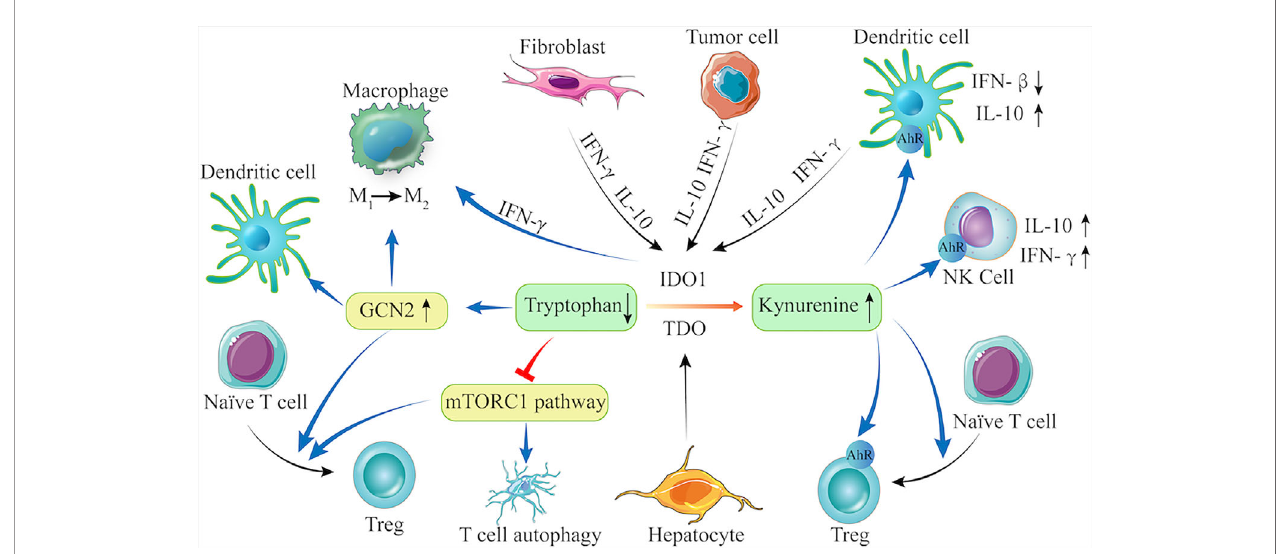
FIGURE 1 | The Try-IDO1/TDO-KYN pathway and immune escape. IDO1 is constitutively expressed in fi broblast, tumor cells, and DCs, and can be upregulated by IL-10 and IFN- g , whereas TDO is only expressed in hepatocytes. When IDO1 and TDO are activated, they promote Try degradation and KYN accumulation. Try depletion can activate GCN2 and inhibit the mTORC1 signaling. The KYN can bind to AhR in NK cells, Tregs, and DCs. Therefore, the Try-IDO1/TDO-KYN pathway cooperatively modulates immune cells (e.g., DCs, macrophage, Treg, and T cells) to regulate anti-in fl ammatory cytokine production, leading to enhanced immunosuppression in the tumor